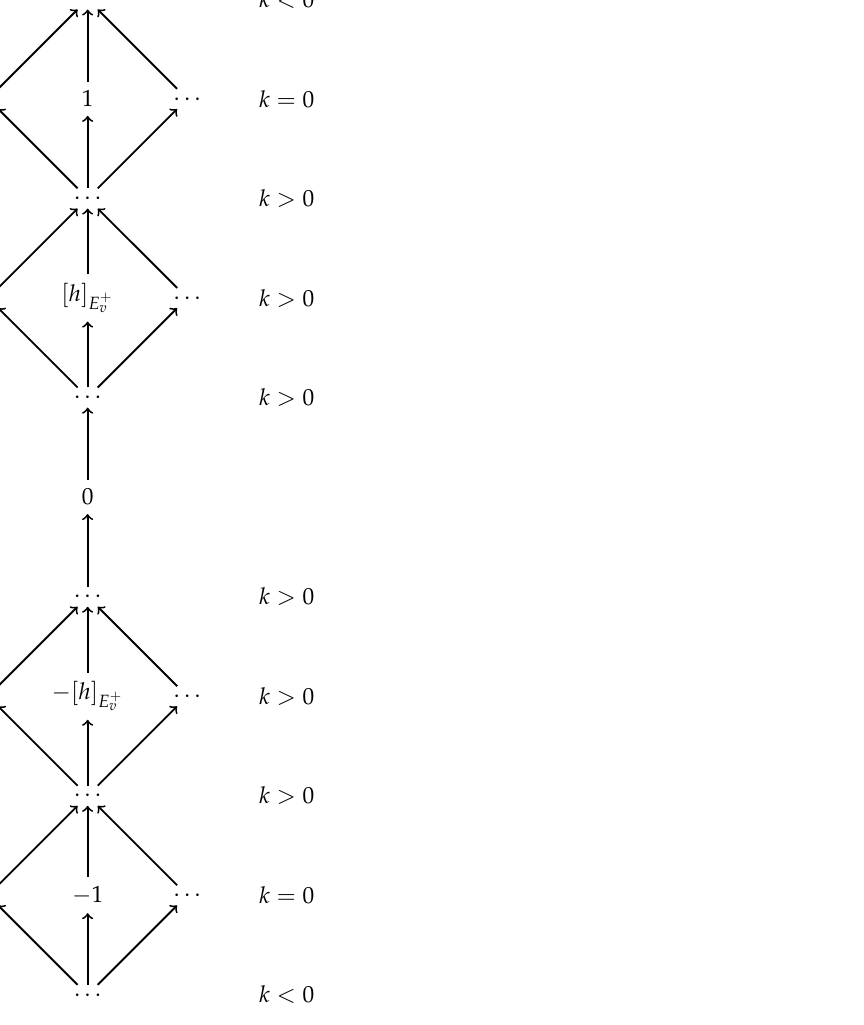
Figure 3. The graph associated to the strict partial order induced by P on R ( X )